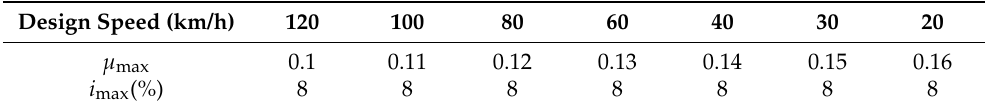
Table 2. Ultimate minimum radius transverse force coefficient and ultra-high transverse slope